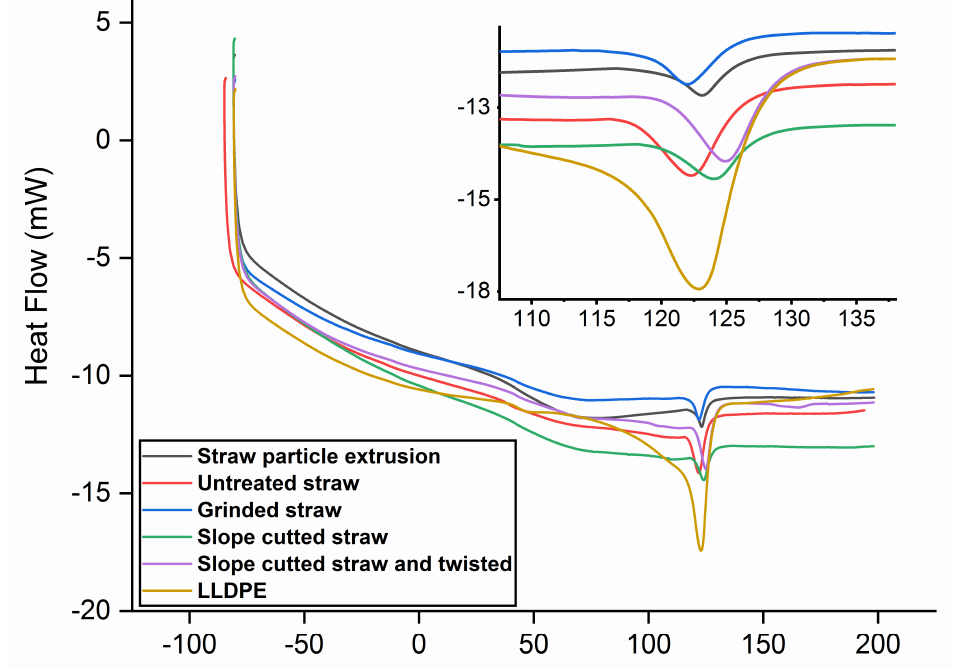
Figure 7. DSC thermograms of straw/LLDPE